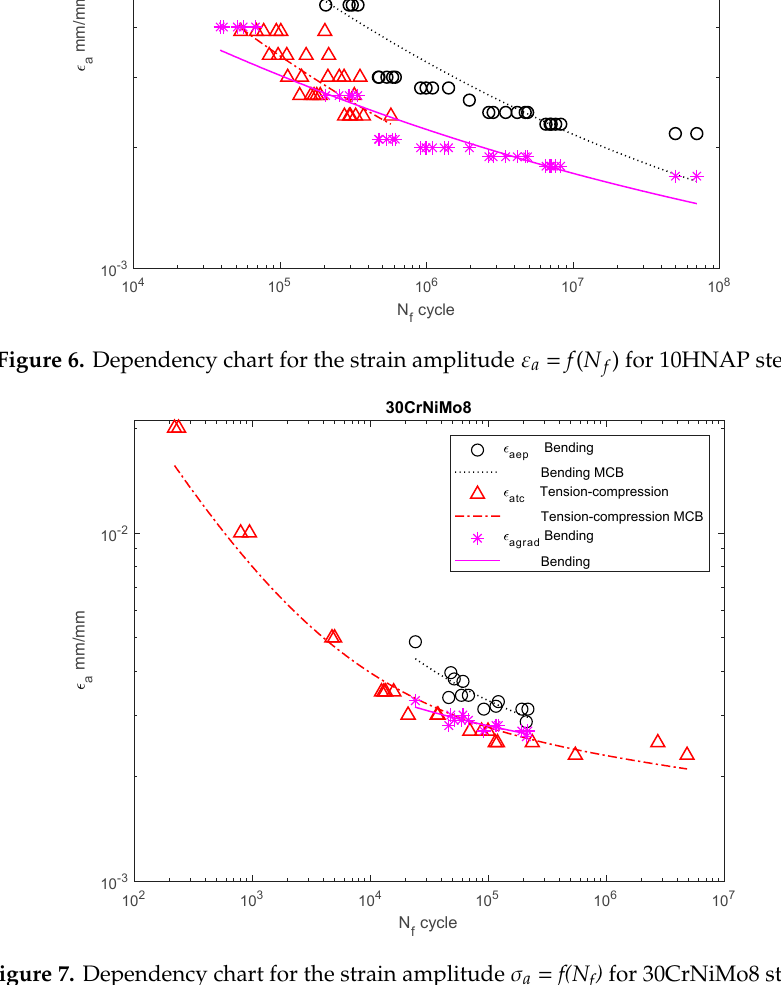
Figure 7. Dependency chart for the strain amplitude σ a = f(N f ) for 30CrNiMo8 steel.